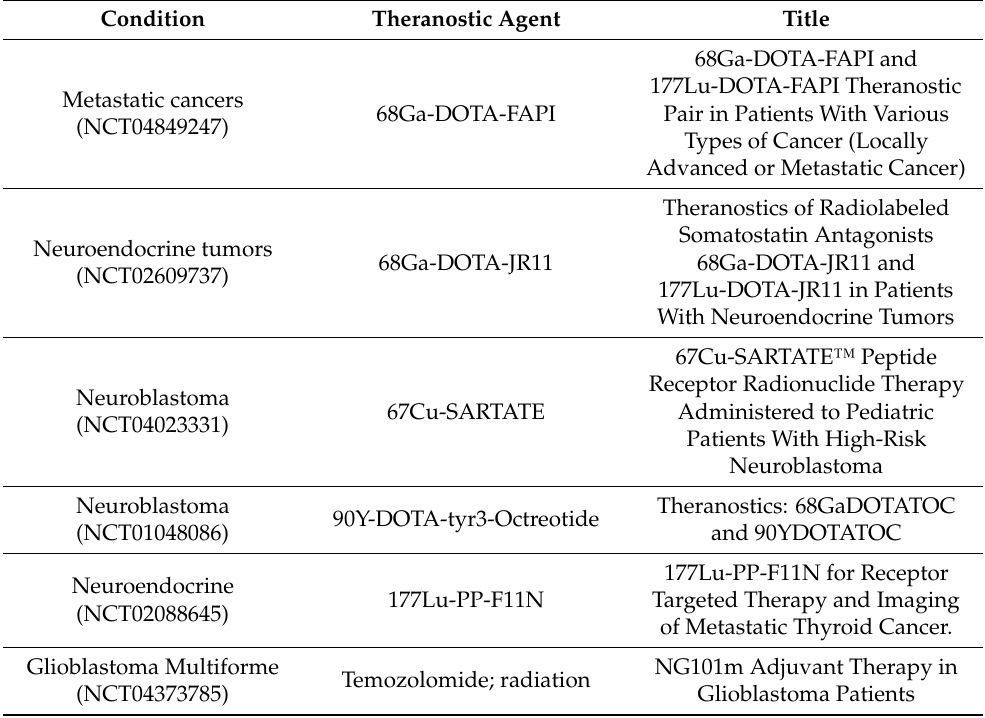
Table 2. Theranostic-based clinical trials focused on brain or metastatic